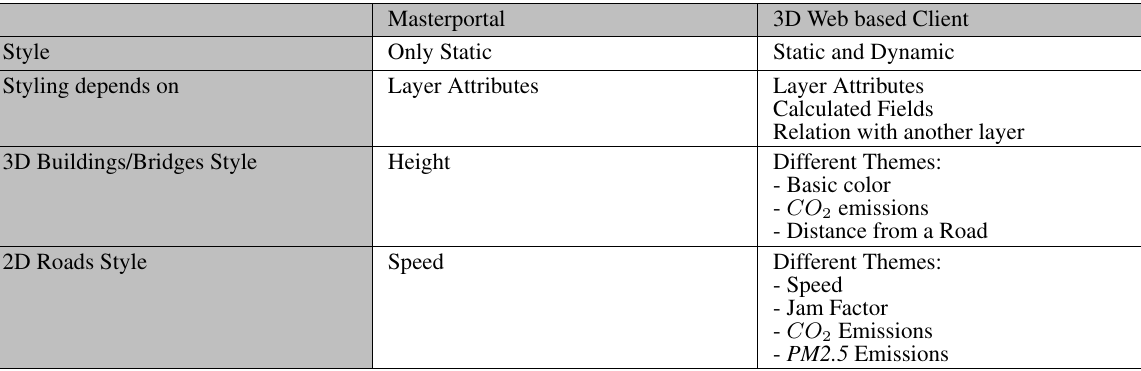
Table 3. Data styling comparison between Masterportal and developed 3D web